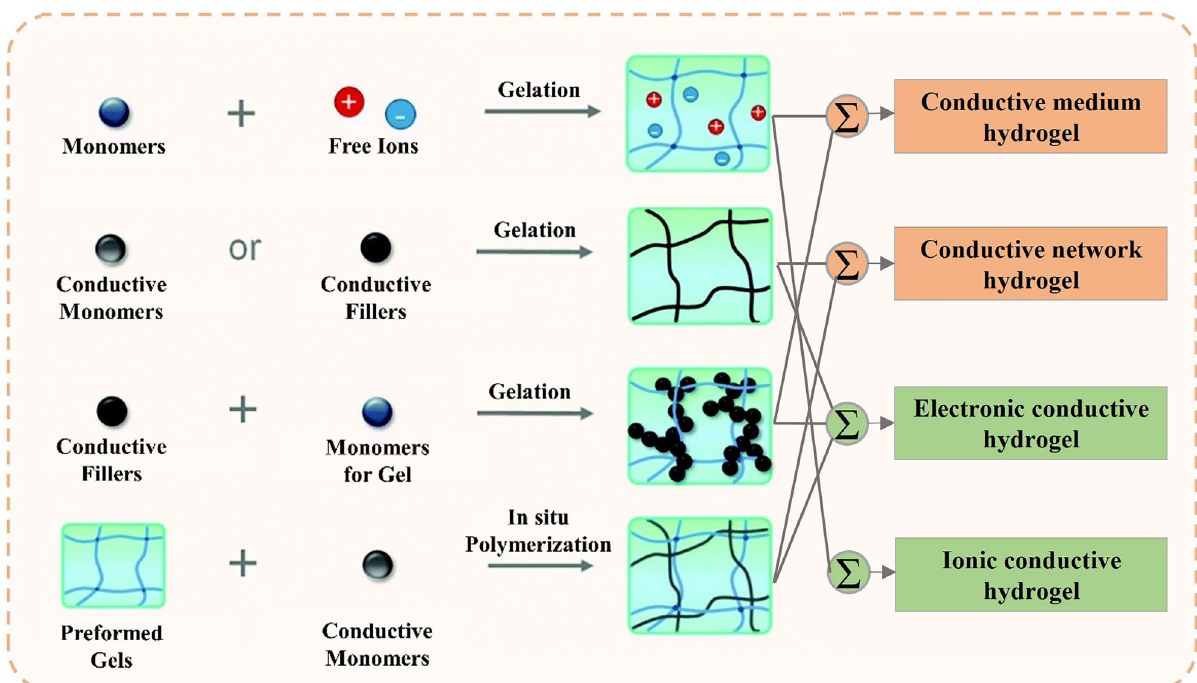
Fig. 4 The main approach to produce conductive hydrogels and classification of hydrogels based on different principles [110]. Reproduced with permission. Copyright 2020, The Royal Society of